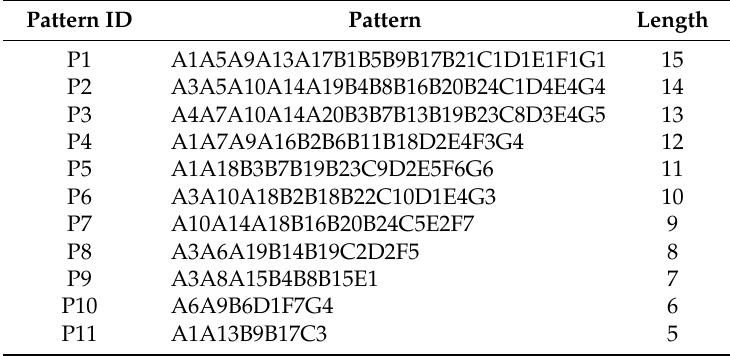
Table 2. Subsequence patterns for Anomaly Evaluator experiment.